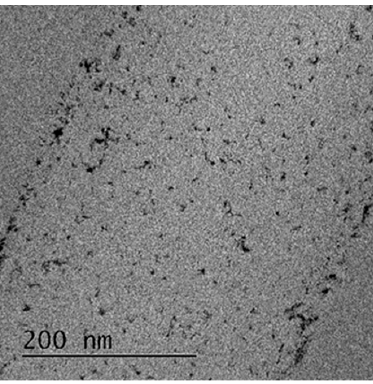
Figure 5. Cross-sectional TEM image of precipitated Pt nanoparticles into an ion-track-etched capillary in one of the polyimide films.